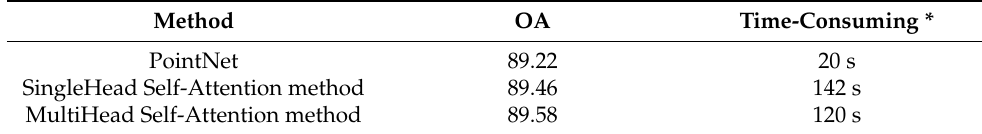
Table 3. The OA and time results of group